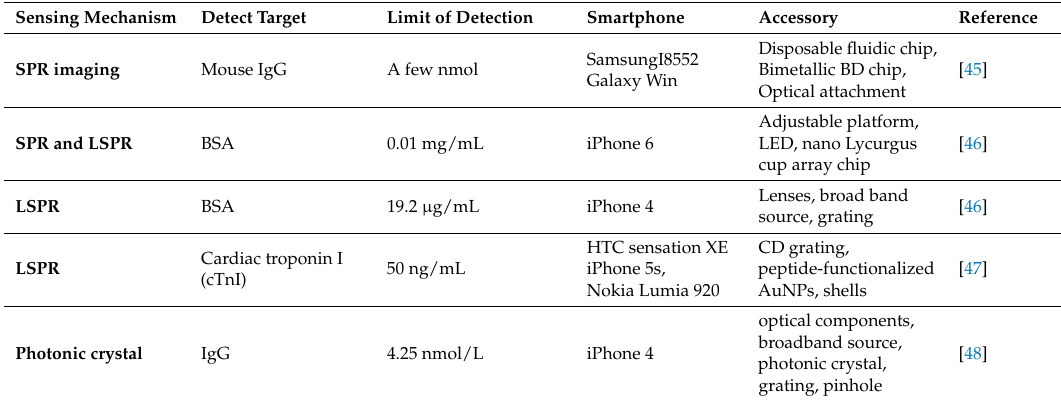
Table 3. Biosensor based on spectrum on smartphone